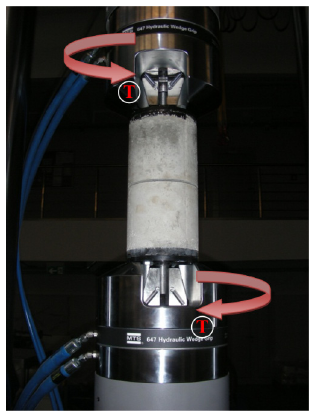
Fig. 4. The experimental stand with the fixed device subjected to torsion ( T –